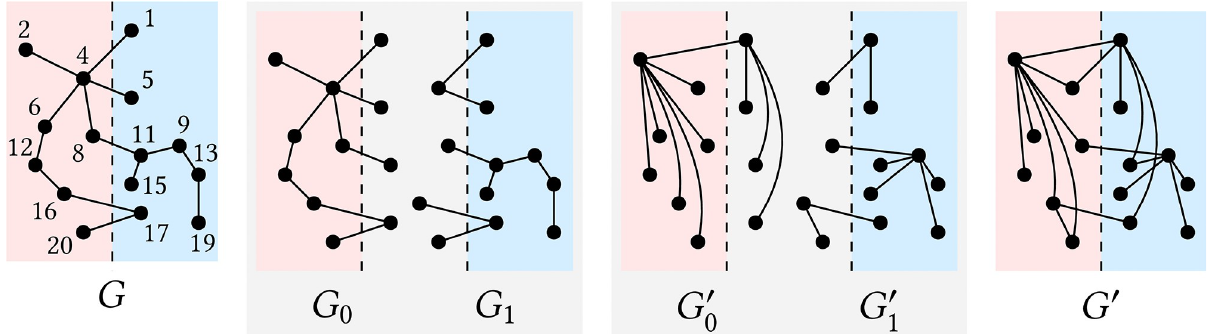
Fig 3. An example of UniStar when the number of partitions ρ = 2. Red and blue areas represent 0 and 1, respectively. UniStar divides G into overlapping subgraphs G 0 and G 1 , computes G 0 in the same way. Then, G 0 is the union of G 0